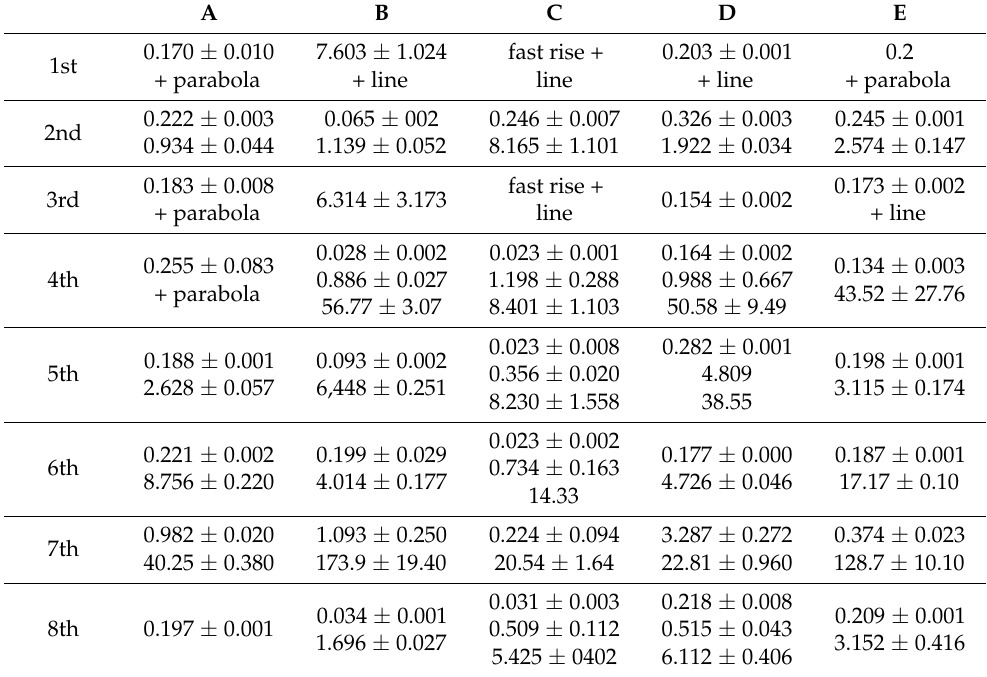
Table 6. Time constants estimated from the transients depicted in Figures 13 and 14 ± 95% confidence intervals. In the few cases in which the objective function is shallow in the neighbourhood of the minimum and the confidence interval estimates are thus very large, these have been simply